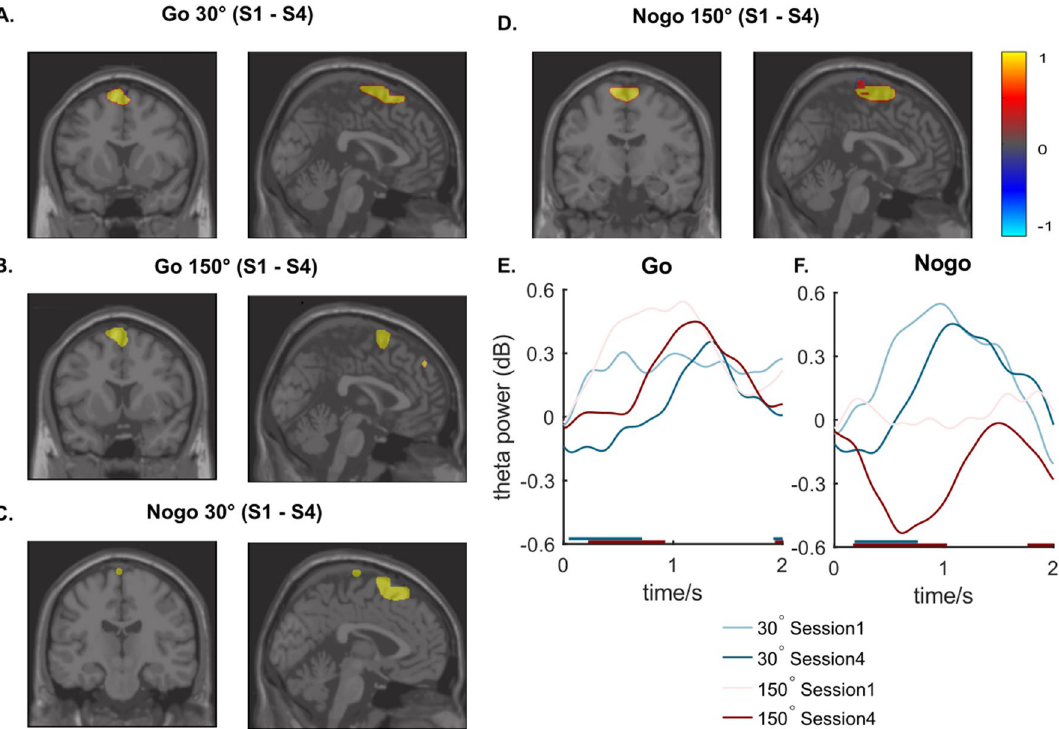
Figure 4. Anatomical regions of sources and task-evoked theta activity in source level. ( A – D ) present the anatomical regions showing a significant difference of task-related TBA between session S1 and session S4 in each condition. Figure parts ( E ) and ( F ) show the average baseline-normalized theta (4–7 Hz) activities (in dB) at the source level in the time window between 0 and 2 s after stimulus presentation. The bold lines parallel to x-axis indicate the time when the significant difference between S1 and S4 is observed. Red and blue colors represent the 30° and the 150° conditions, respectively.